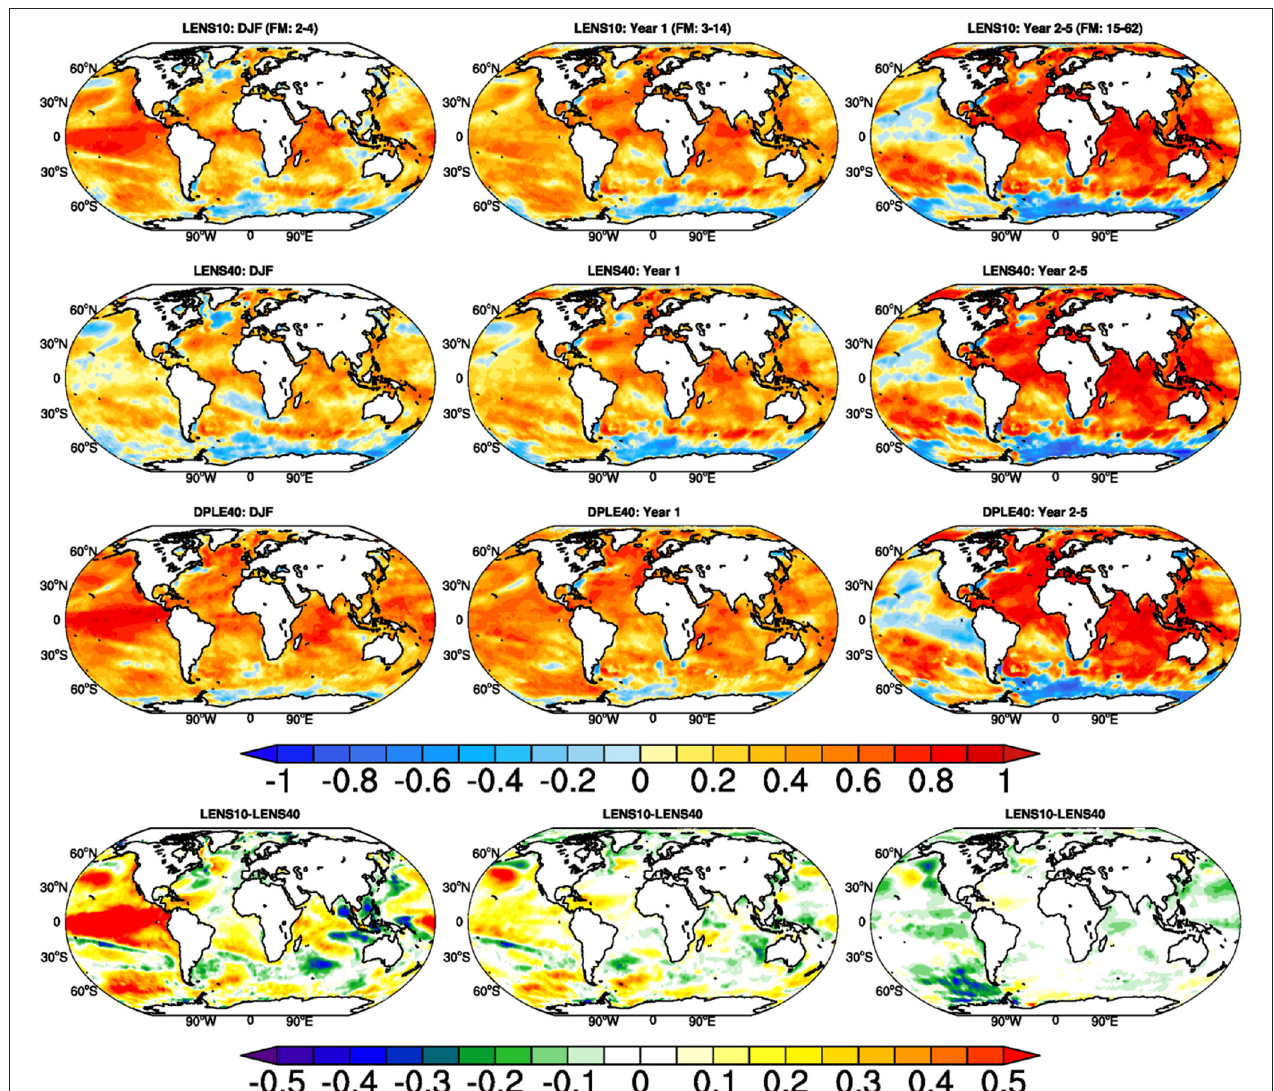
FIGURE 6 | Forecast skill, measured as anomaly correlation against HadISST, for LENS10 (top row), LENS40 (second row), DPLE40 (third row), and skill difference between LENS10 and LENS40 (bottom row). Left, center and right columns represent forecast skill of the mean of forecast months 2–4, forecast months 3–14, and forecast months 15–62,